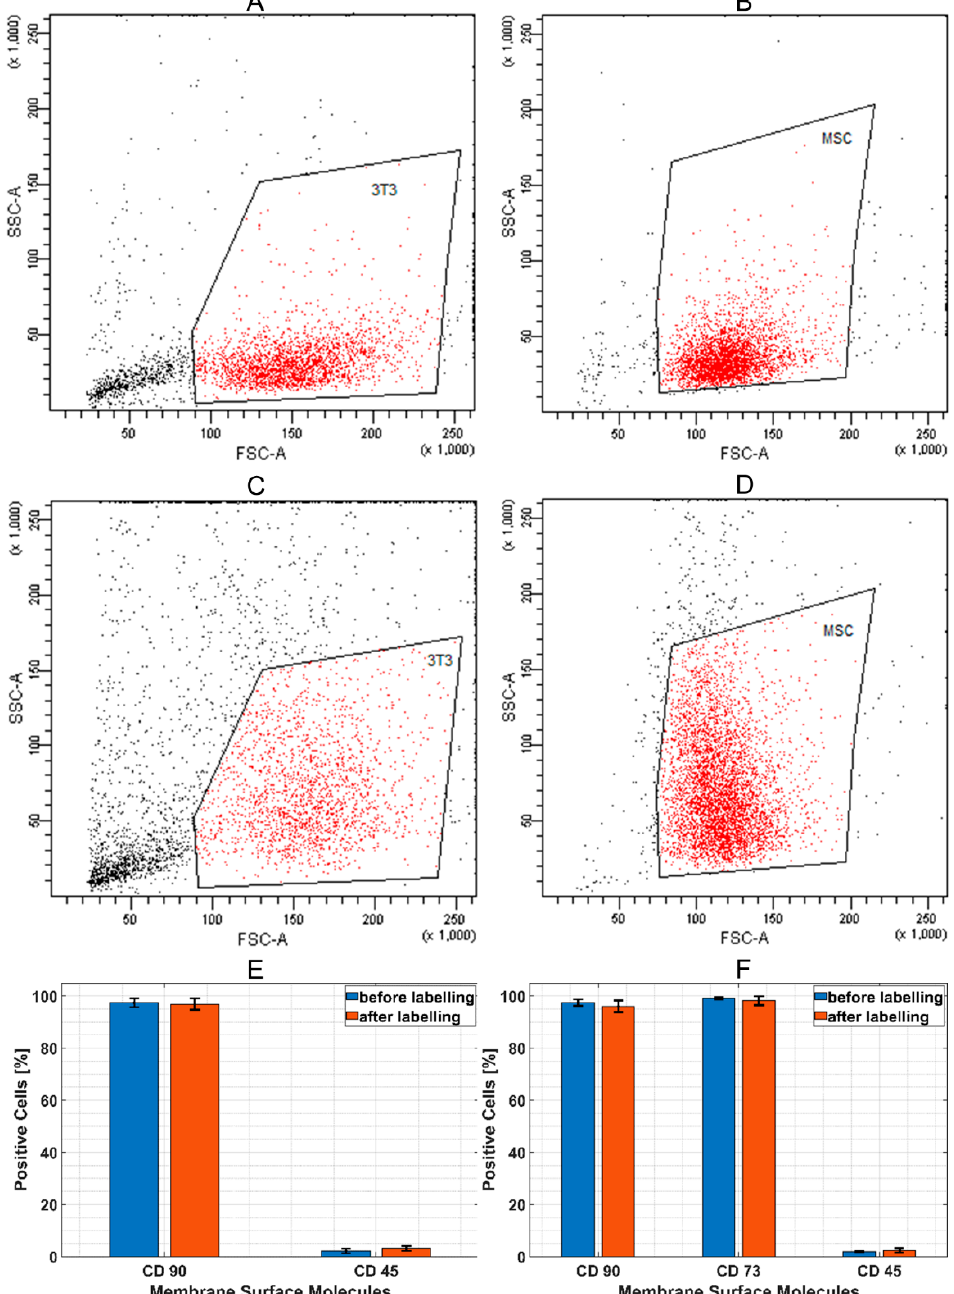
Figure 3. Flow cytometry analysis of labelled cells. Site scatter and forward scatter: ( A ) 3T3 before labelling; ( B ) mesenchymal stromal cell (MSC) before labelling; ( C ) 3T3 after 24 h of labelling; ( D )MSC after 24 h of labelling; ( E ) quantification of CD90 and CD45 positive 3T3; ( F ) quantification of CD90, CD73, and CD45 positive MSC.